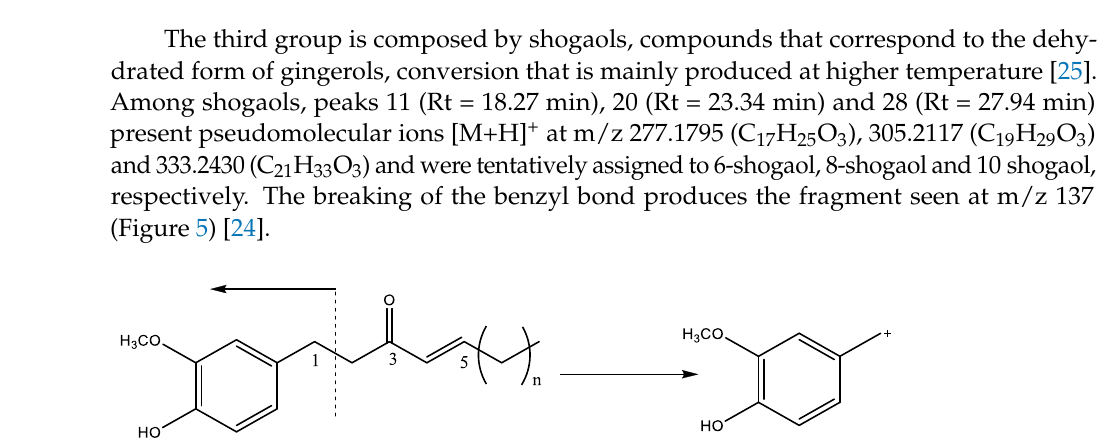
Figure 5. Fragmentation pathway for shogaol compounds 11 ( n = 6), 20 ( n = 8), 28 ( n = 10). Another group of compounds are gingerdiols, the ketone reduction products of gin- gerols [11]. Gingerdiols present two hydroxyl groups ( − OH groups) that dehydrate and provide adducts [M+H-2(H 2 O)] + and [M+H-H 2 O] + , the first one being the predominant ad- duct for peaks 6 (Rt = 15.72 min) and 17 (Rt = 21.23 min) at m/z 289.2173 (C 19 H 29 O 2 ) and 317.2378 (C 21 H 33 O 2 ), respectively, corresponding to 8-gingerdiol (C 19 H 32 O 4 ) and 10-ginger-